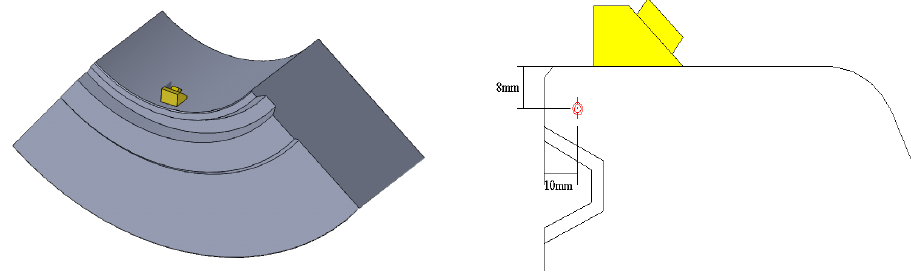
Figure 8. Probe arrangement and